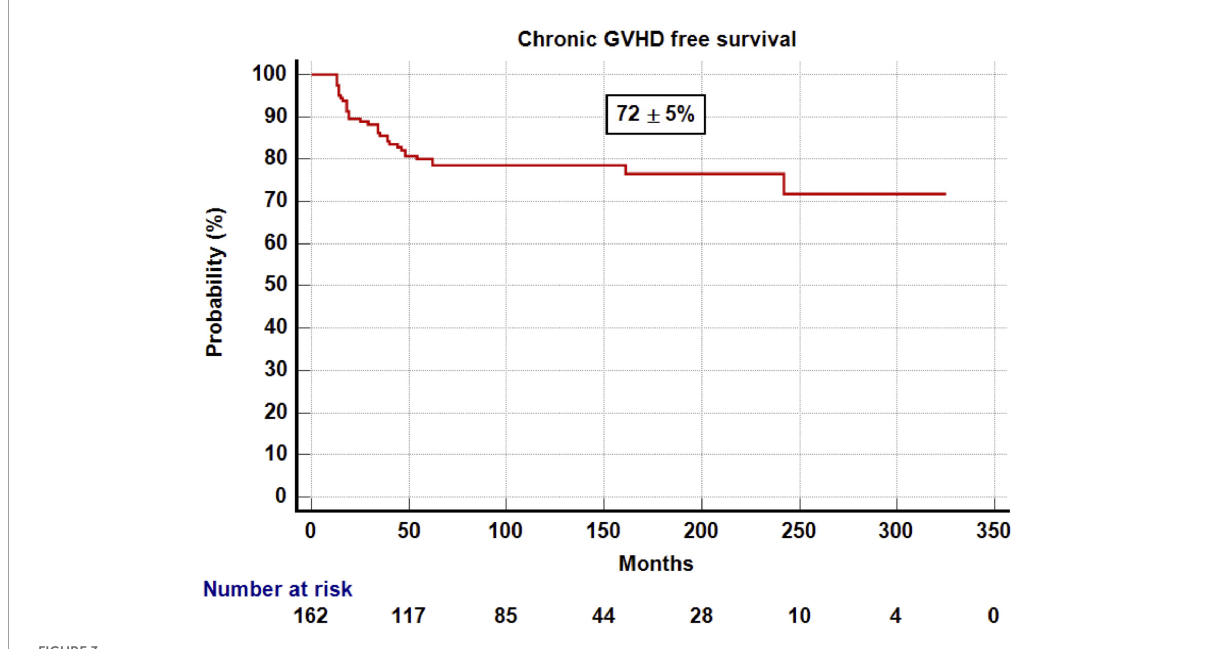
FIGURE3 Kaplan–Meier estimation of CRFS after 1 year post-transplantation.